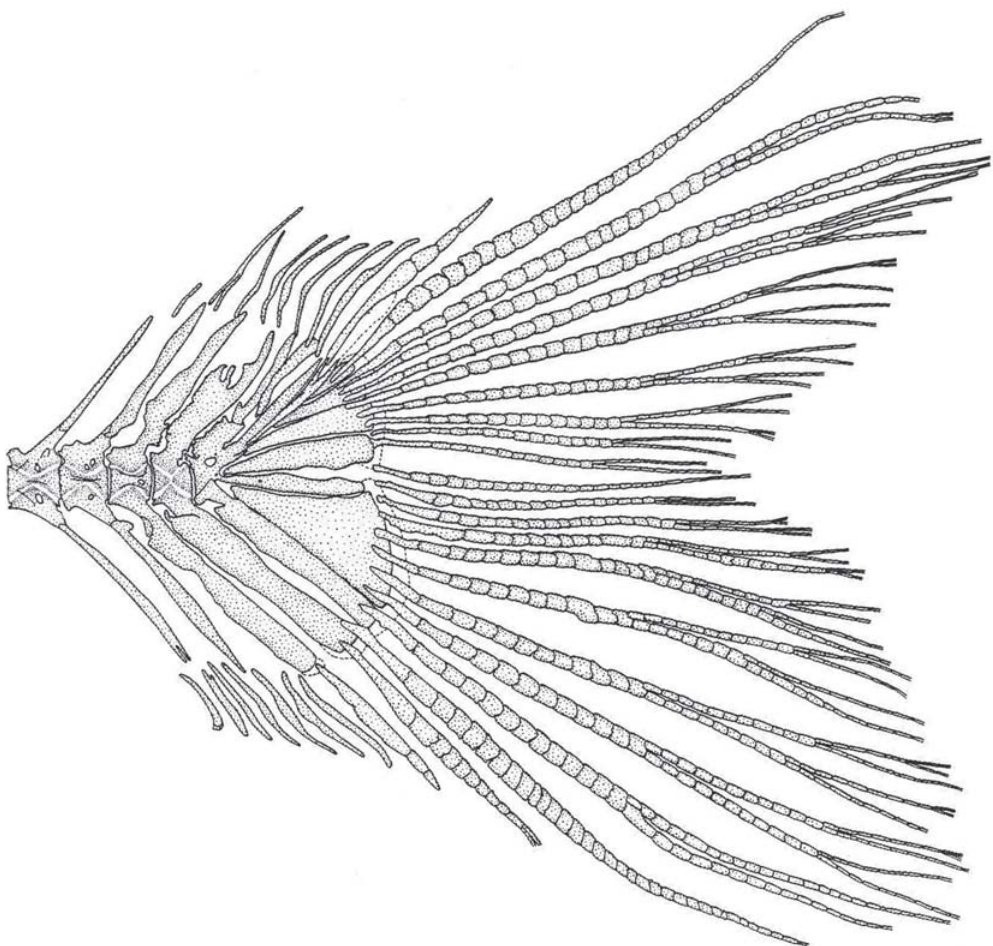
Fig. 25. Glandulocauda caerulea , adult male, USNM 326756, 39.4 mm SL; caudal skeleton and fin rays. Cartilage outlined by dashed lines. Lateral view, left